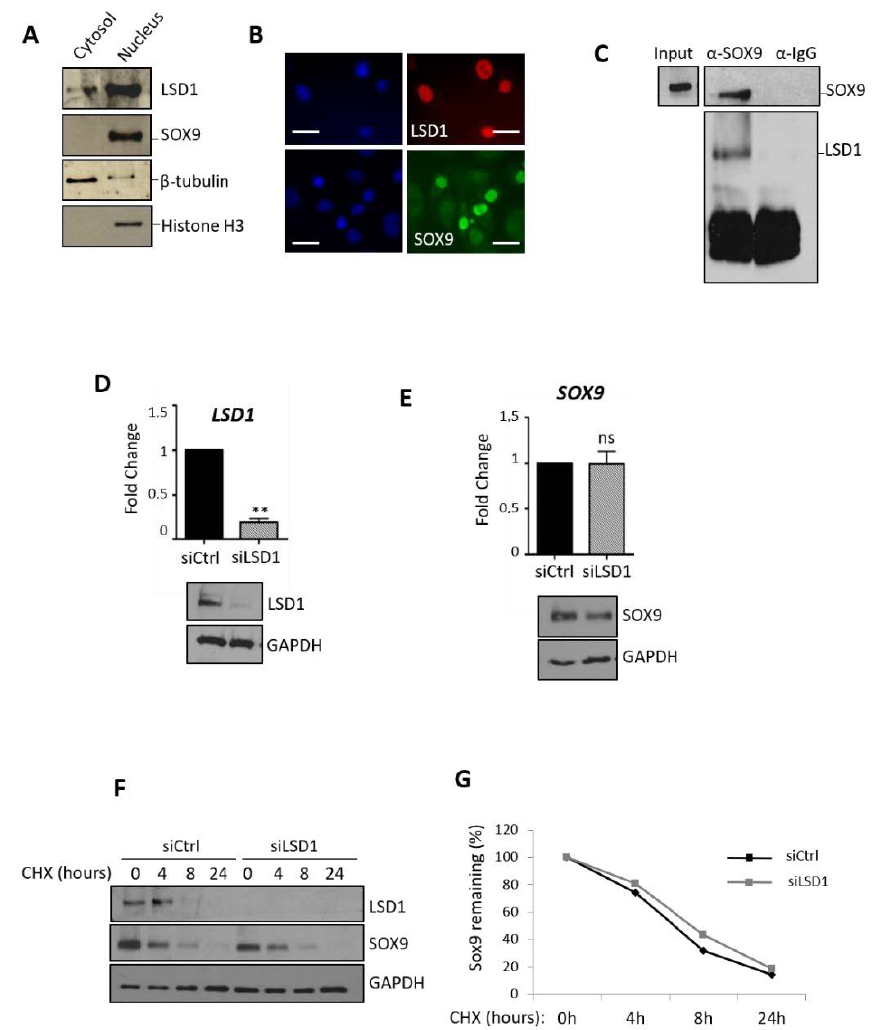
Figure 3. LSD1 interacts with SOX9 in human chondrocytes. ( A ) Cytosolic and nuclear fractions were analyzed by Western blot and tested for the expression of SOX9 and LSD1. β -tubulin and Histone H3 were used as cytosolic and nuclear markers, respectively. ( B ) Localization of LSD1 and SOX9 proteins was assessed by immunofluorescence analysis (scale bar: 10 µ m). Nuclei were counterstained with Hoechst (left panels). ( C ) Immunoprecipitation of SOX9 was realized using an anti-SOX9 antibody, then anti-LSD1 was probed to test if it co-immunoprecipitates ( n = 3). ( D , E ) Knock-down of LSD1 was realized following transfection of human chondrocytes with siRNA. Real-time PCR was performed from at least 5 independent experiments. Results are presented as relative mRNA levels of LSD1 and SOX9 normalized to RPLP0 , after LSD1 knock-down in human chondrocytes (Student’s t -test ** p < 0.01, ns: non significant). Western blot was performed to detect LSD1 or SOX9 protein expression after siRNA transfection. ( F ) Protein synthesis was inhibited with cycloheximide (CHX) incubation and a time course from 0 to 24 h was performed prior to the analysis of SOX9 protein stability by Western blot ( n = 3). ( G ) Corresponding quantification was performed using ImageJ software.